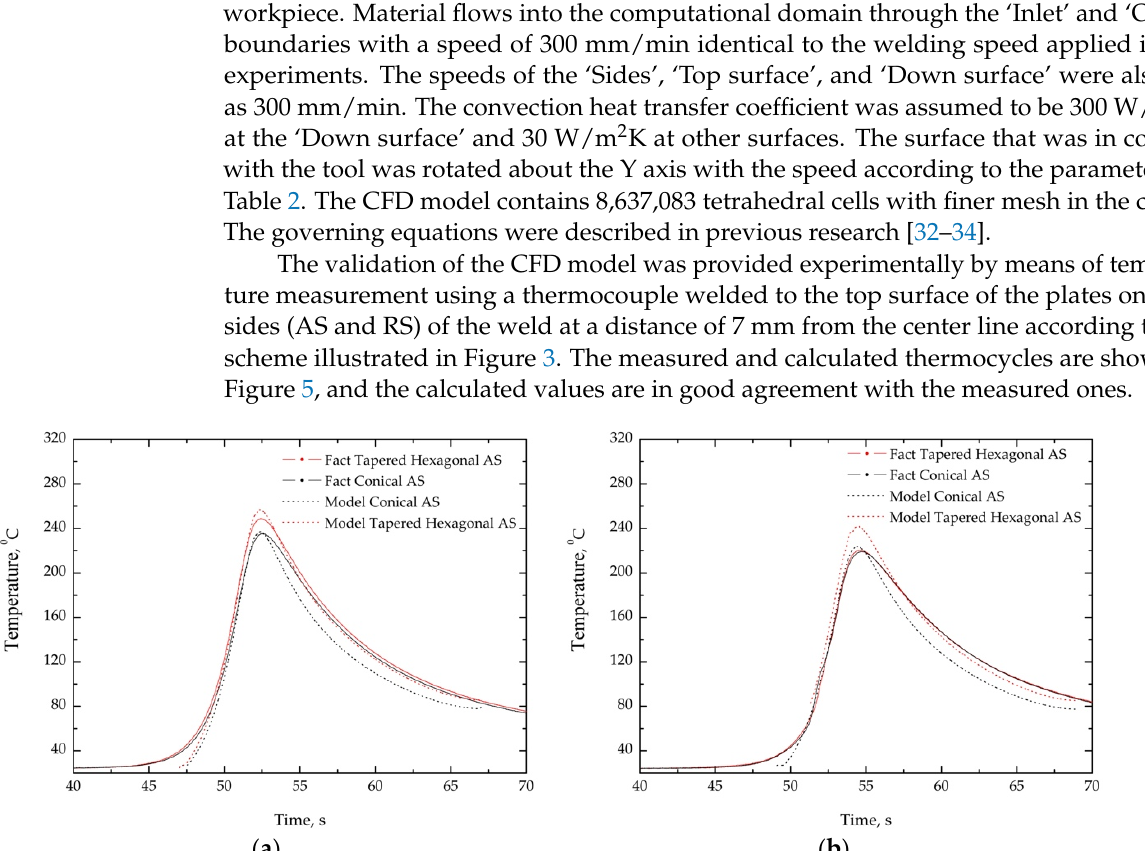
Figure 4. Scheme of the domain, tool position, and tool geometry.